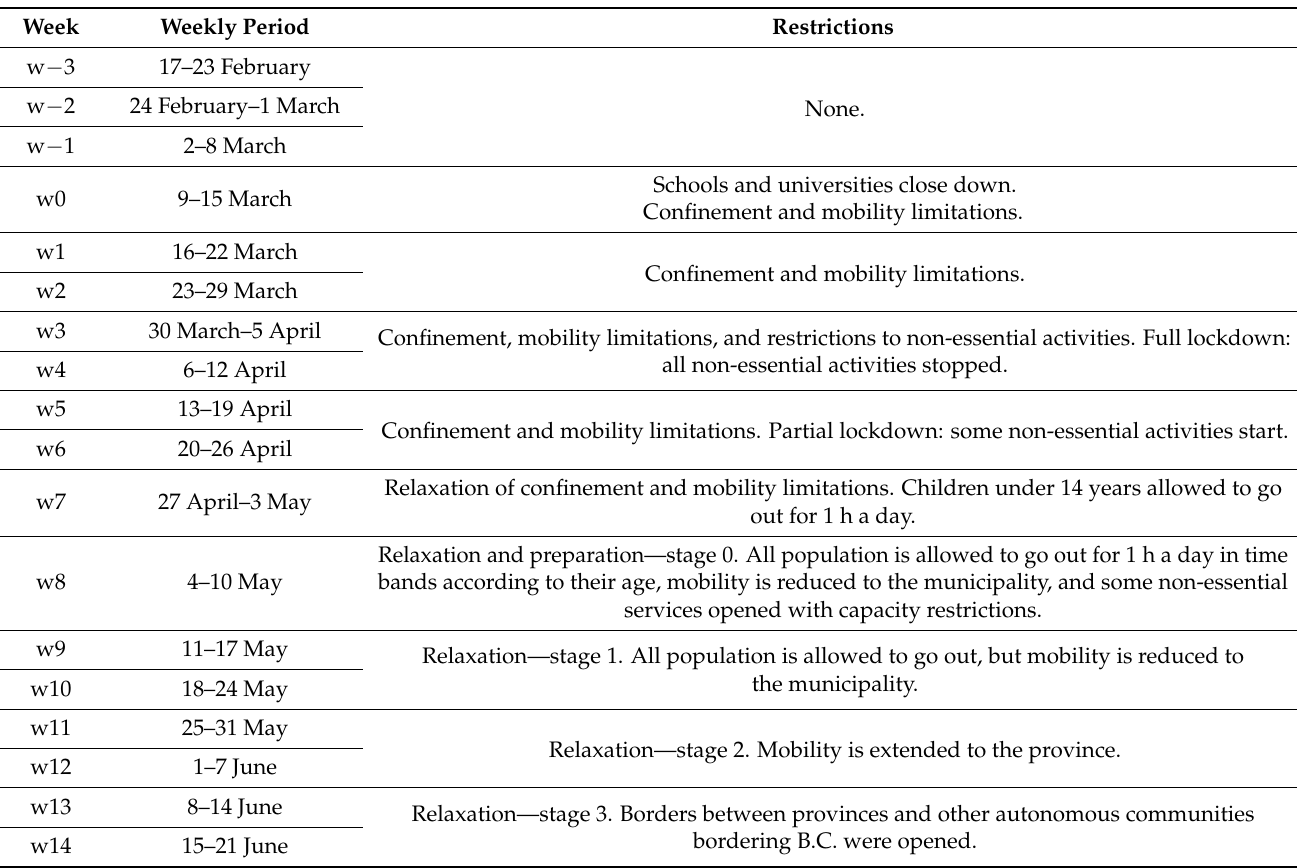
Table 2. Weekly periods studied and mobility and confinement restrictions applied in the Basque